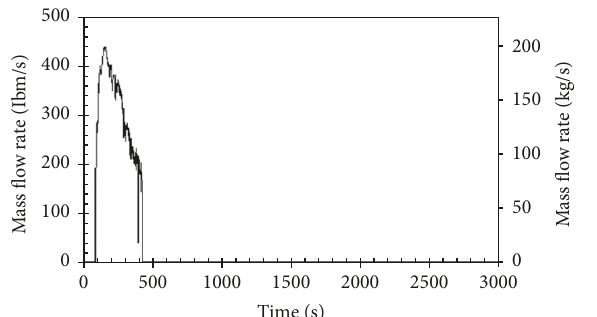
Figure 23: 10-inch Accumulator-2 injection rate (NOTRUMP code) [7].